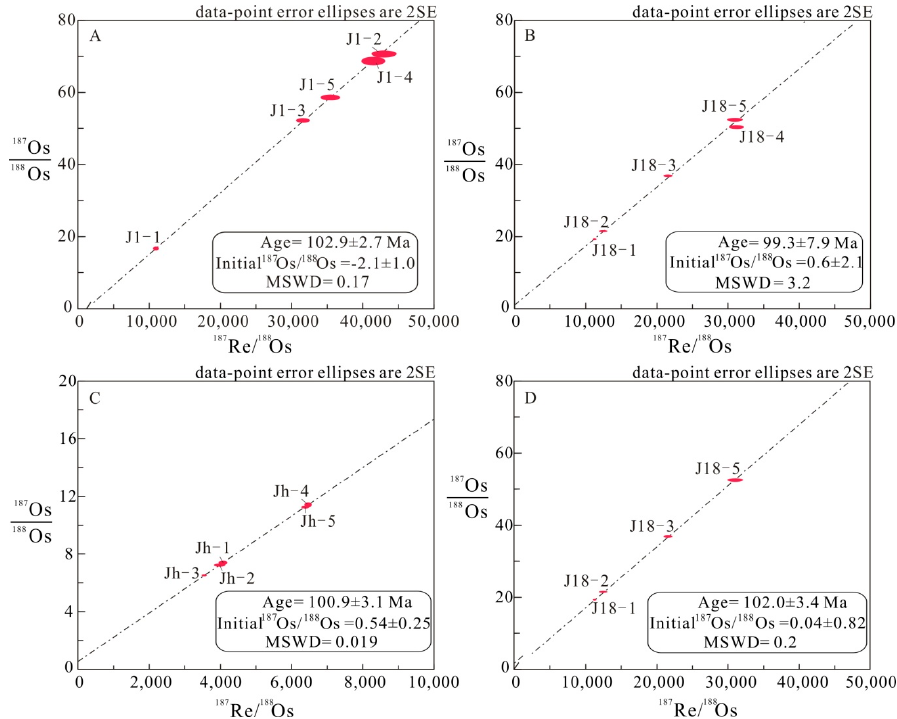
Figure 7. Re–Os isochron plots of stage 1–3 pyrites from the Jinchang Gold Deposit. ( A ) Isochron age of five analyses of Py 1 ; ( B ) isochron age of five analyses of Py 2 ; ( C ) isochron age of five analyses of Py 3 ; ( D ) isochron age of four analyses (excluding J18-4) of Py 2